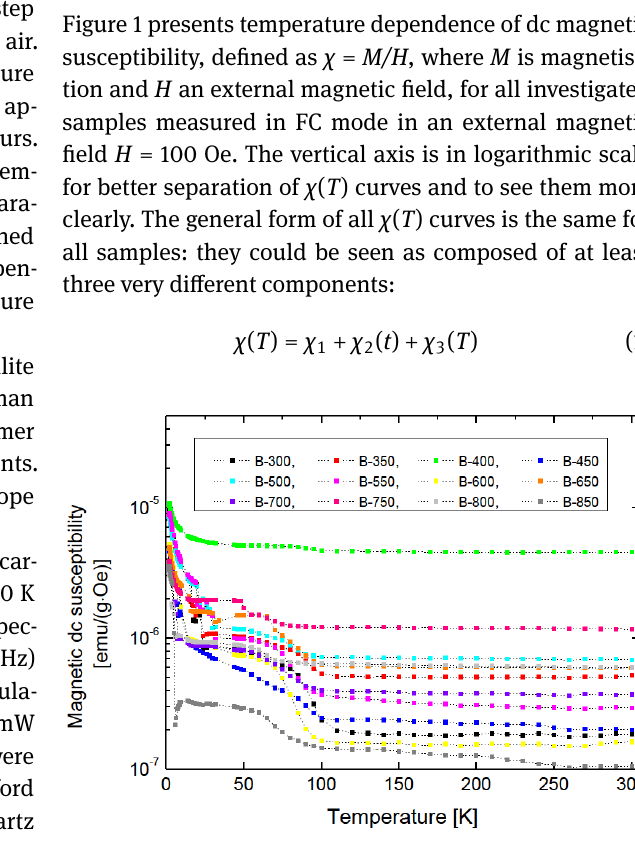
Figure 1: Temperature dependence of dc magnetic susceptibility of all investigated samples measured in FC mode in an external magnetic field H = 100